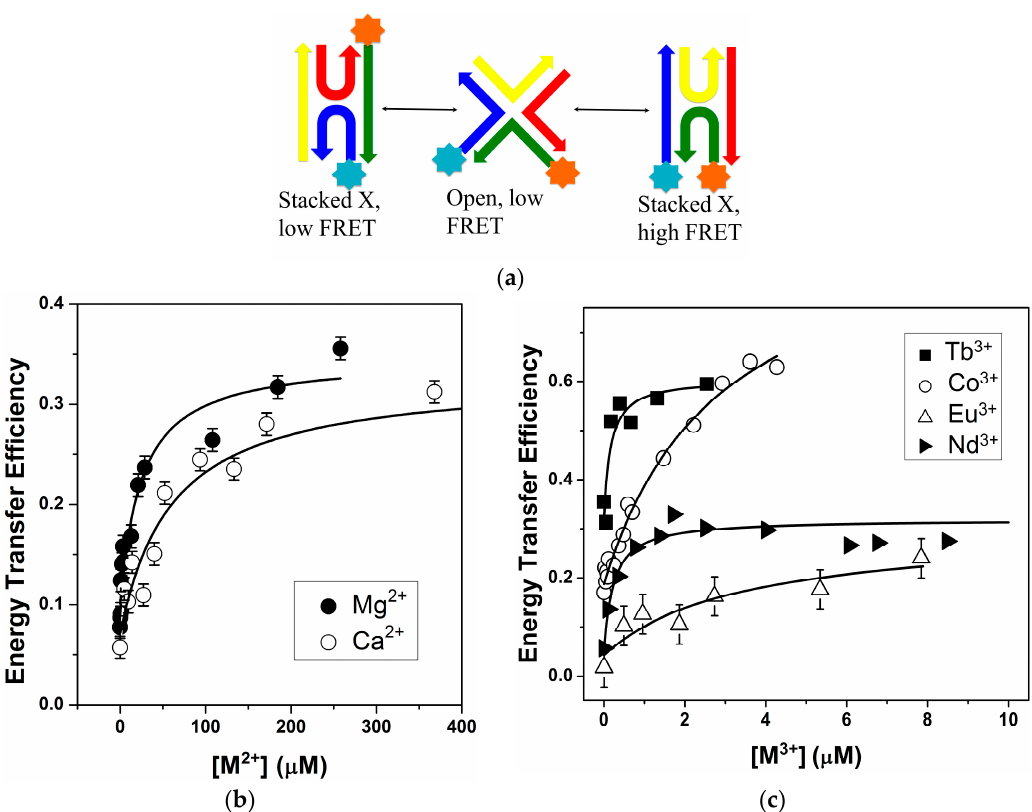
Figure 1. Increasing multivalent cation concentration folds the junction bringing the labeled arms of the DNA closer together and increases transfer efficiency. ( a ) Schematic of the junction folding that is induced by ion binding. The R and X strands have a linker at the 5 ′ end for attachment of the fluorescein (FAM) and tetramethylrhodamine (TAMRA) dyes, which are in close proximity in the high FRET, isoII conformation; ( b ) Fitting of binding curves yielded apparent K d values of 55 ± 19 and 22 ± 8 μ M for Ca 2+ and Mg 2+ , respectively; ( c ) Fitting of binding curves yielded apparent K d values of 4 ± 0.3, 0.1 ± 0.1, 3 ± 2 and 0.7 ± 0.3 μ M for [Co(NH 3 ) 6 ] 3+ , Tb 3+ , Eu 3+ and Nd 3+ , respectively. Titrations of cobalt hexamine contained 5 mM Na + , while all other titrations contained only 0.5 mM Na + . For clarity of presentation, the Co 3+ and Tb 3+ data are offset from the y-axis by +0.15 and +0.3, respectively, and only the error associated with the Eu 3+ data is shown. The other ion binding curves have similar error and error bars. All titrations were performed at 10 °C in a 10 mM Tris–HCl pH 7.4 buffer.